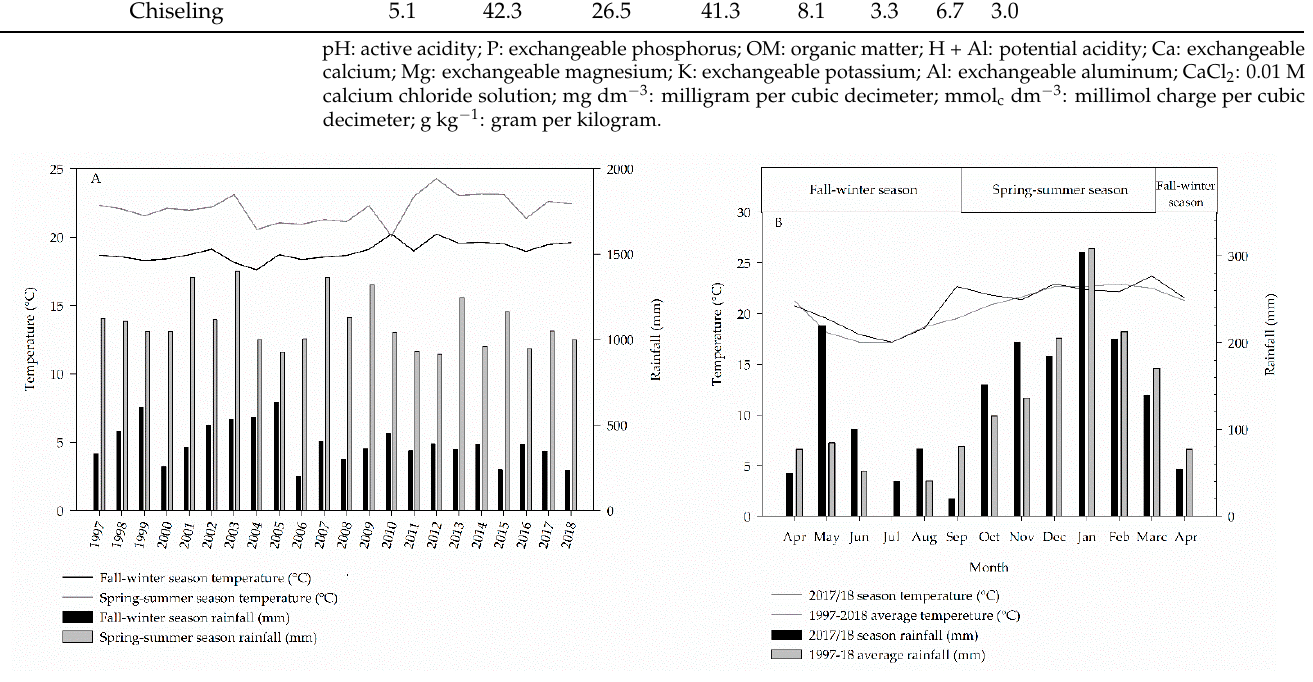
Figure 4. Means temperature and rainfall in fall–winter and spring–summer seasons since experiment implementation (1985–2018) ( A ), and means monthly temperature and rainfall between the years 1985 and 2018 and during the 2017/18 season ( B ).